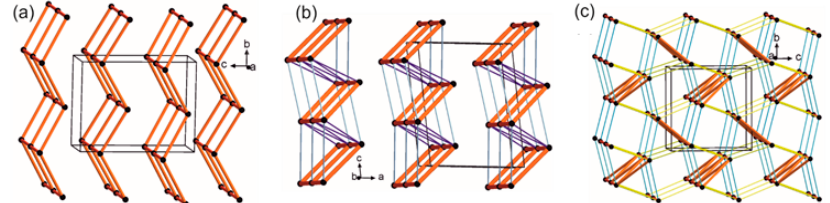
Figure 13. Simplified hydrogen-bonded networks showing LSAMs in proline crystals: ( a ) L-proline, ( b ) rac-proline, ( c ) L-thioproline. The black dot represents a center of gravity of the molecule, red and orange lines stand for N-H … O hydrogen bonds, blue and yellow lines for C-H … O and C-H … S contacts, respectively.